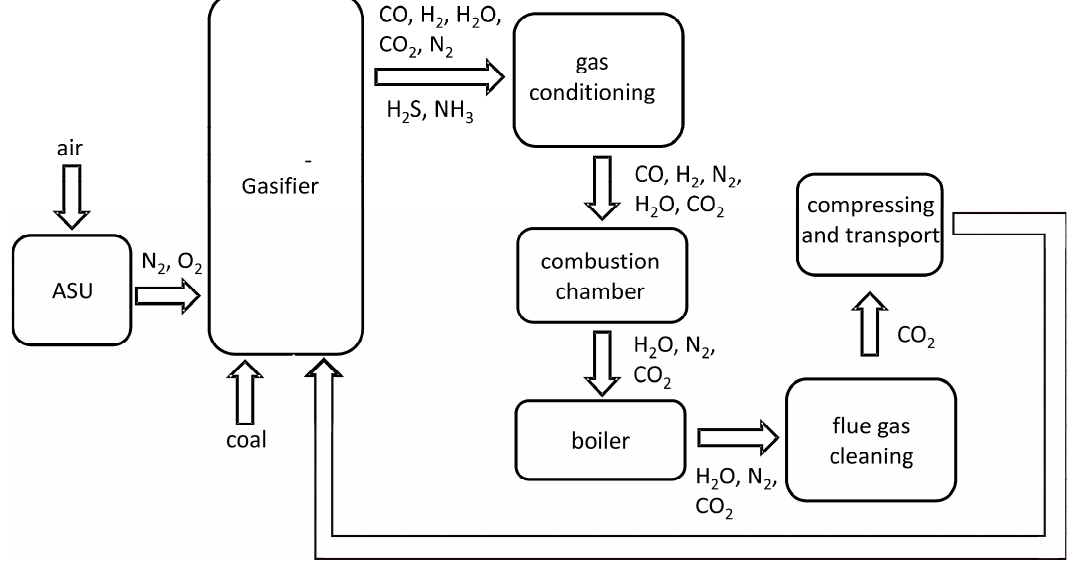
Figure 5. Scheme of a coal-fired IGCC in oxyfuel mode.